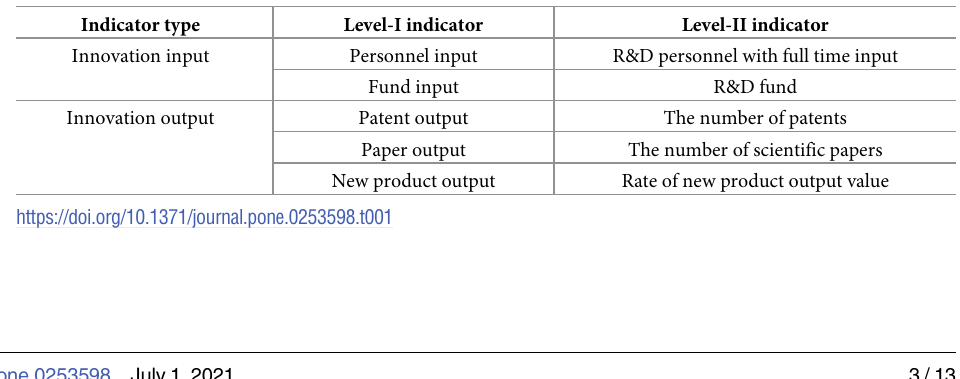
Table 1. The evaluation indicator of innovation